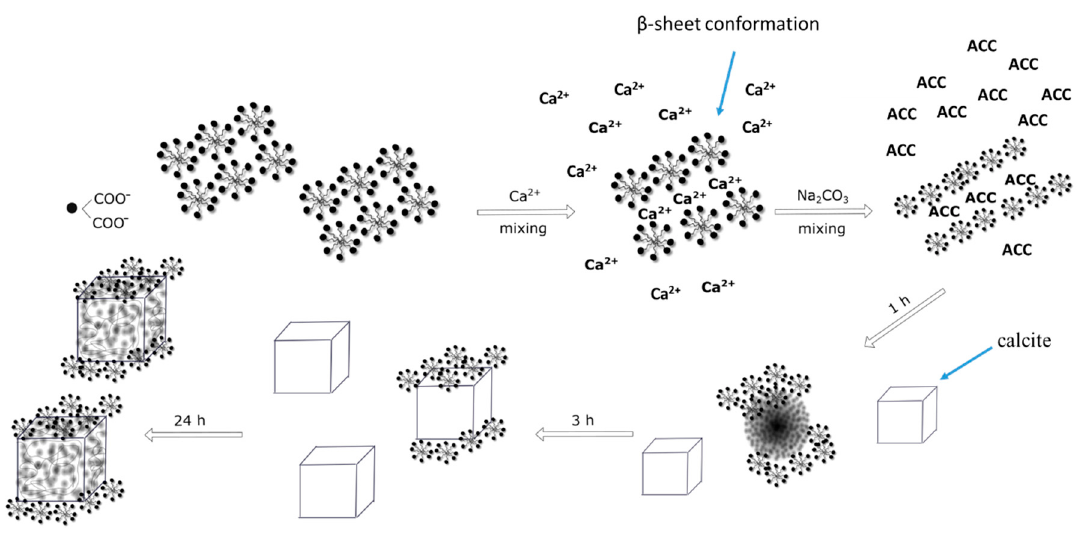
Figure 8. Mechanism of mesoporous calcite formation.